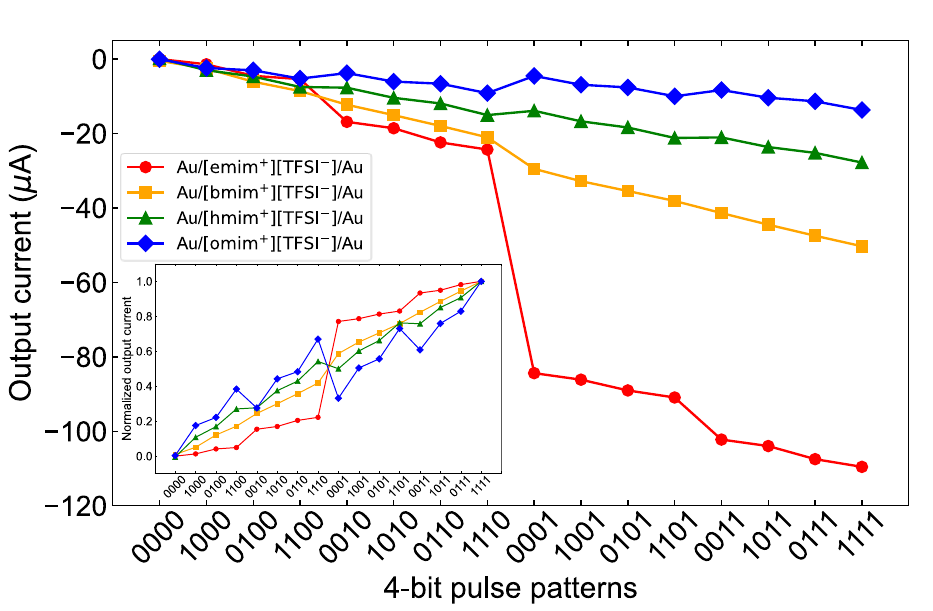
Figure 3. Output current ( I out ) extracted from dynamic current responses of Au/[emim + ][TFSI − ]/Au, Au/ [bmim + ][TFSI − ]/Au, Au/[hmim + ][TFSI − ]/Au, and Au/[omim + ][TFSI − ]/Au, shown in Fig. S3a–d, as a function of 4-bit pulse patterns. The inset indicates I out normalized with their maximum absolute value of I out (<